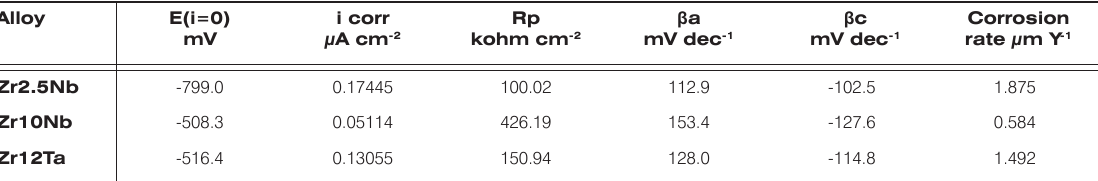
Table 7. Fitted parameters obtained using the R Materials Fig. 3, the diameter of the semicircle becomes larger with increasing Nb content. This indicates an improvement of electrochemical characteristics anda nobler behavior due to the addition of a higher amount of Nb [ 22]. The resistance of the spontaneous oxide films formed on the materials surfaces increased with the increasing content of Nb.